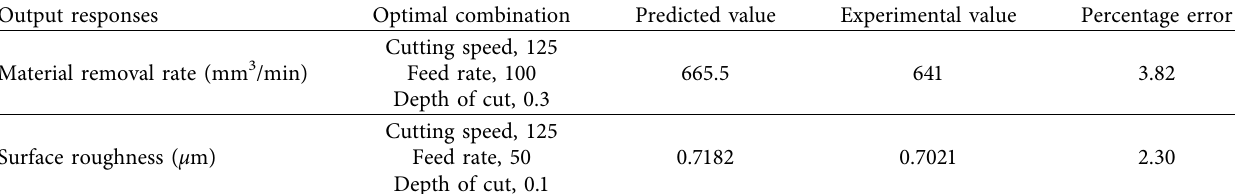
Table 9: Confirmation experiments for the optimum conditions of material removal rate and surface